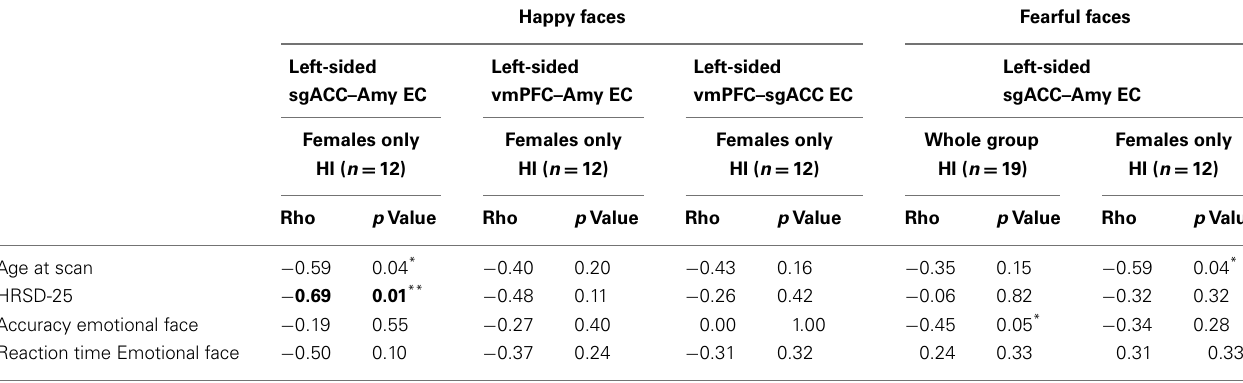
Table 6 | Relation between effective connectivity, clinical, demographic, and experiment performance variables in